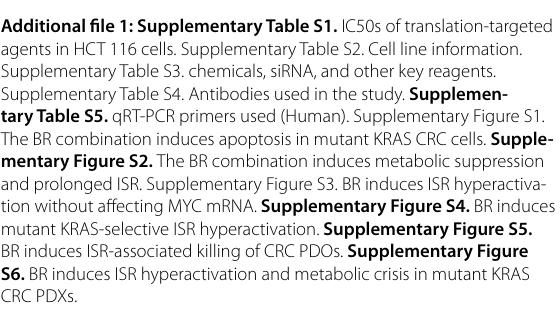
tary Table S5. qRT-PCR primers used (Human). Supplementary Figure S1. The BR combination induces apoptosis in mutant KRAS CRC cells. Supple‑ mentary Figure S2. The BR combination induces metabolic suppression and prolonged ISR. Supplementary Figure S3. BR induces ISR